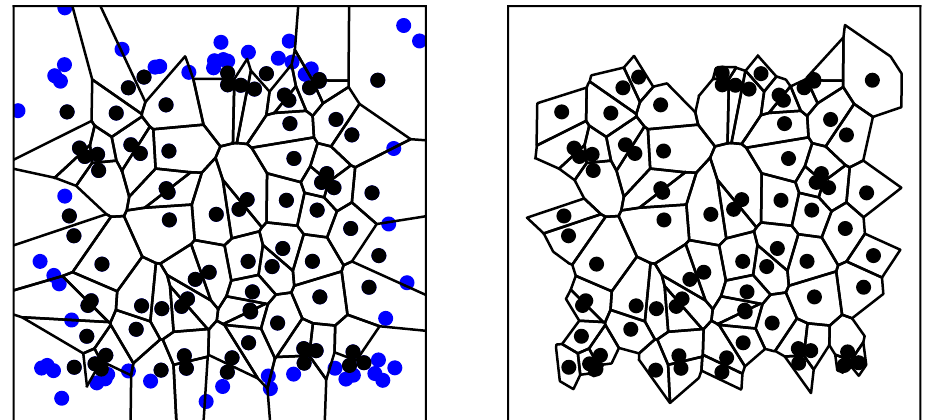
Figure 3. Voronoi tessellation of a randomly-generated wind farm showing wind turbine locations (black dots), ghost point locations (blue dots), and Voronoi cells (black lines). The left panel shows the original tessellation with ghost point projections. The right panel shows the final tessellation with the ghost points